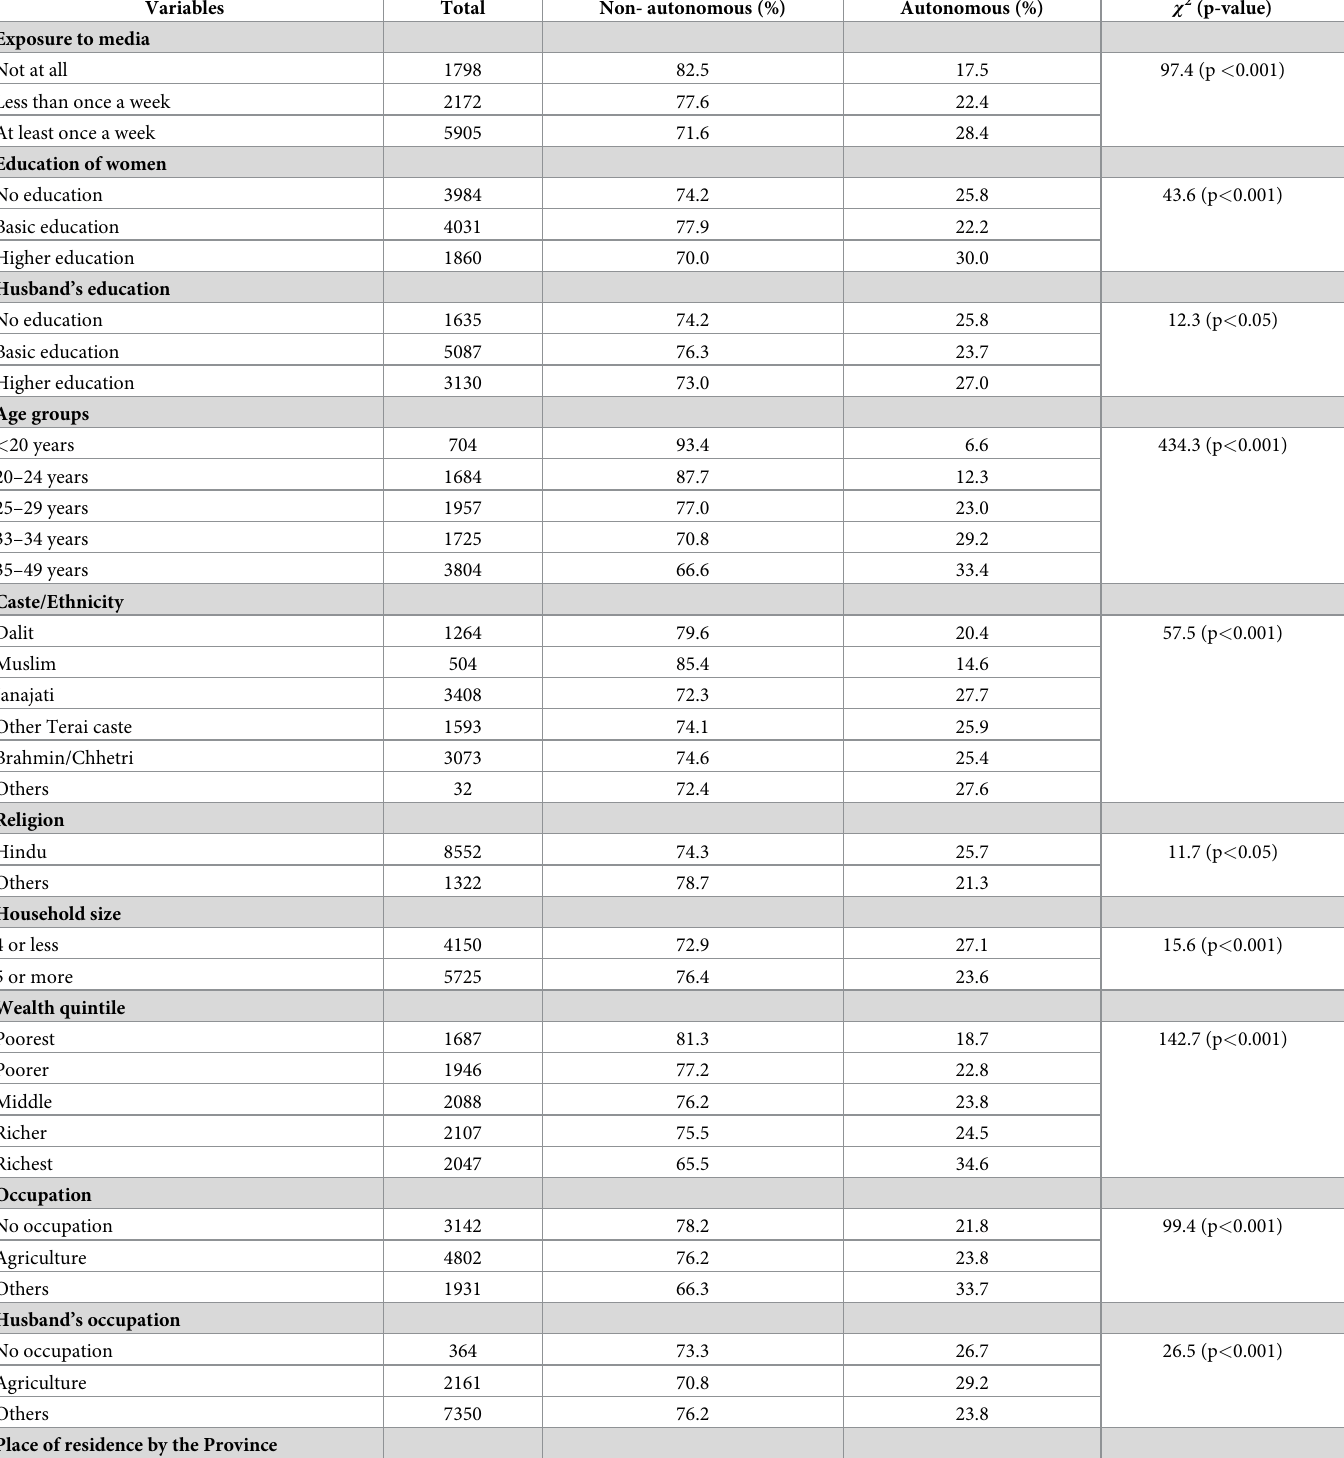
Table 5. Results from a bivariate analysis of women’s autonomy in decision-making and exercise of their